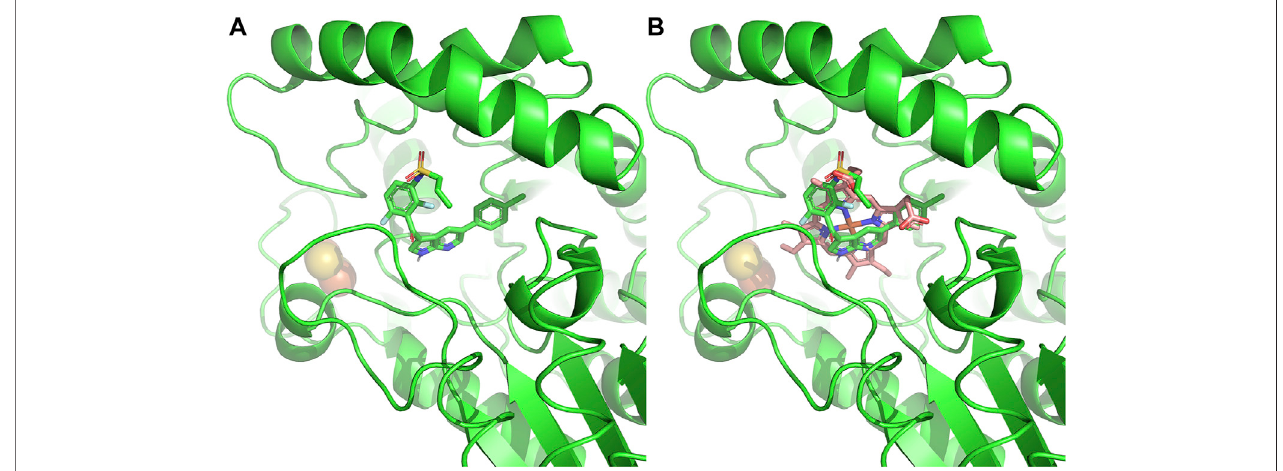
FIGURE 6 | Ferrochelatase – Vemurafenib complex. (A) Cartoon representation of Vemurafenib bound to the active site of human ferrochelatase (PDB ID: 2QD3). (B) Vemurafenib bound to the active site of human ferrochelatase with heme. Molecular docking of was performed using AutoDock Vina (Trott and Olson, 2010) and fi gure created using PyMOL Molecular Graphics System (Schrodinger,